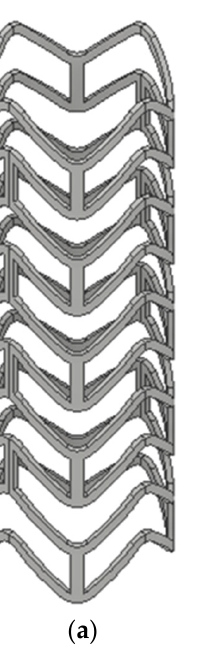
Figure 10. Numerical model for crimping simulation .